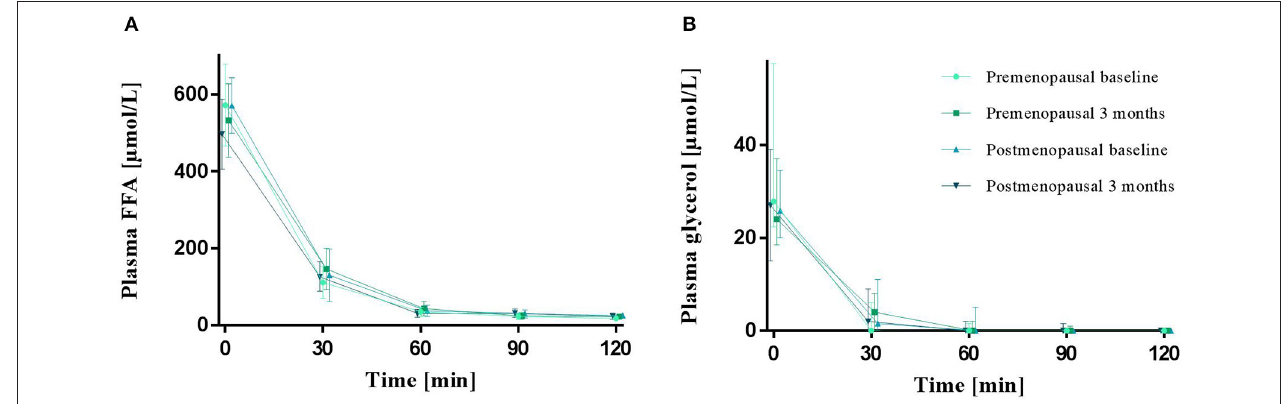
FIGURE 3 | Plasma FFA (A) and glycerol (B) in the fasted state (0min) and during a hyperinsulinemic euglycemic clamp in pre- and post-menopausal women before (baseline) and after 3 months of high-intensity training. Plasma FFA are presented as mean (95% confidence limits) and glycerol as median (25–75 percentile). FFA, Free fatty acids.